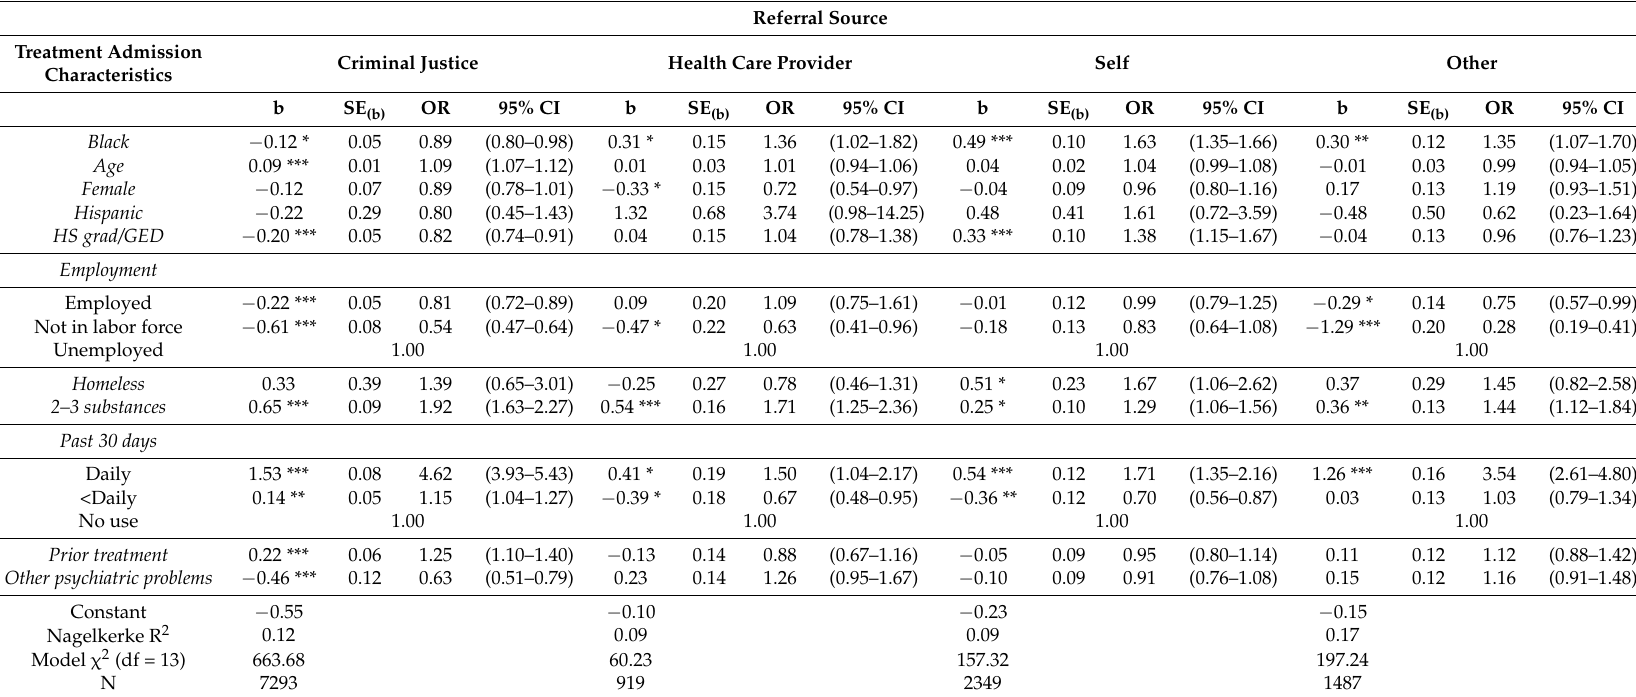
Table 3. Logistic regression estimates for cannabis dependence, by referral source among outpatient admissions, North Carolina,